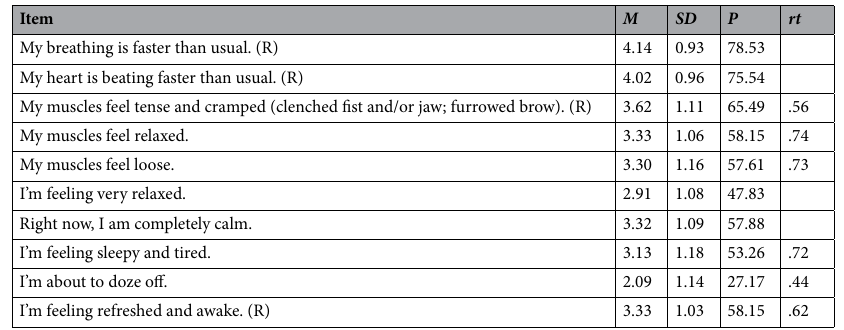
Table 4. Item properties of the 10 items of the RSQ. Rating scale for all items ranged from 1 to 5. P = Popularity index according to Dahl. rt = Item discrimination (item rest correlation) . Reverse-scored items are denoted with (R).